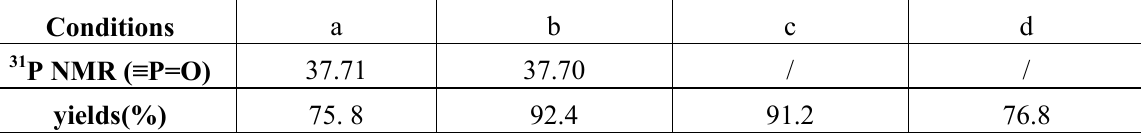
under different conditions